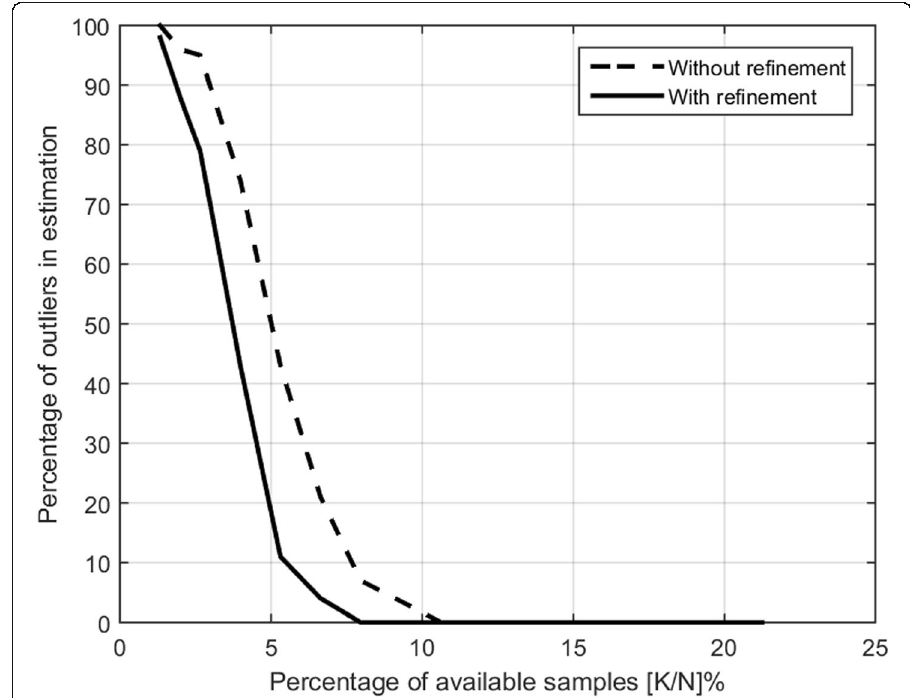
Fig. 5 Percentage of outliers in the IF estimation for the cubic phase signal: dashed line — without refinement; dotted line — with